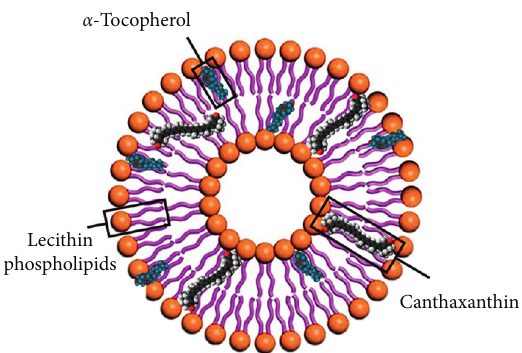
Figure 1: The structure of canthaxanthin- and α -tocopherol- loaded